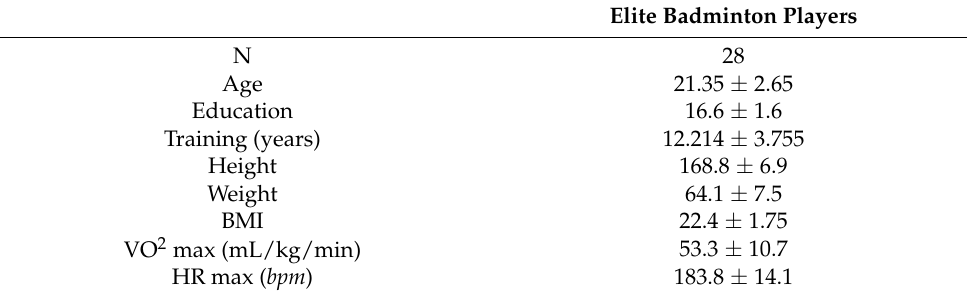
Table 1. Demographic information of participants in this